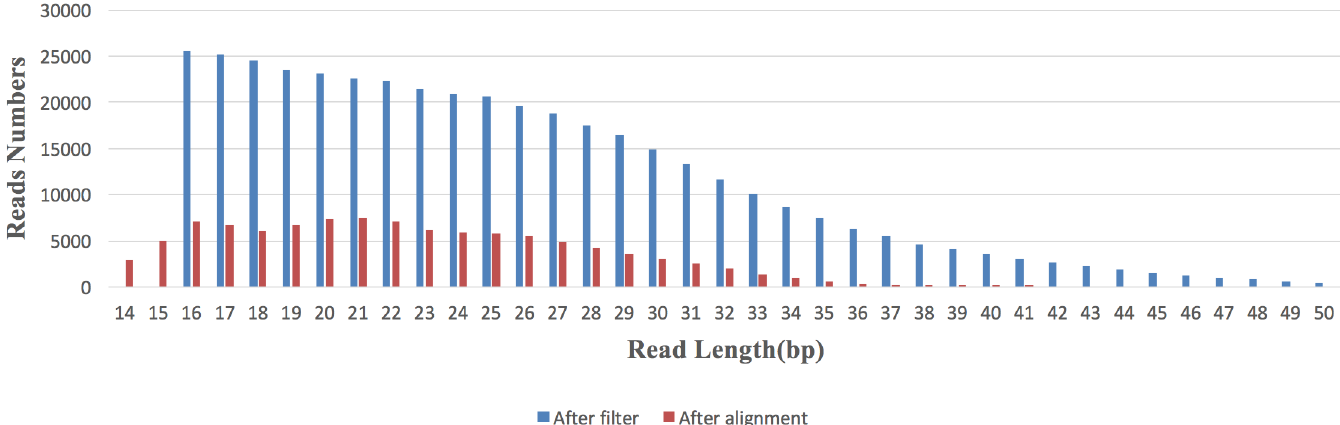
Fig 3. Read length distribution after length and repeat filters (blue bars) and after alignment (red bars).